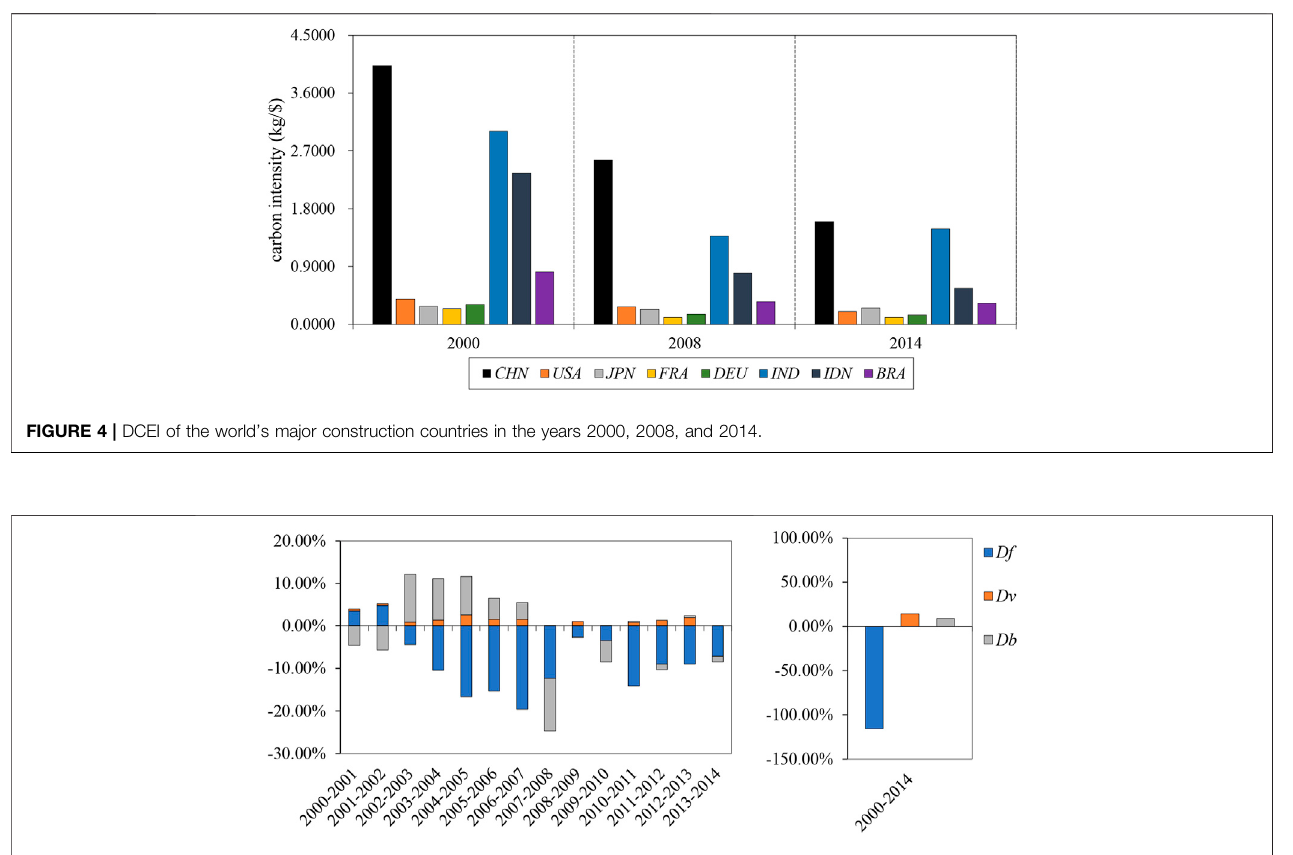
FIGURE 5 | SDA results of changes in DCEI of China ’ s construction industry during 2000 – 2014.